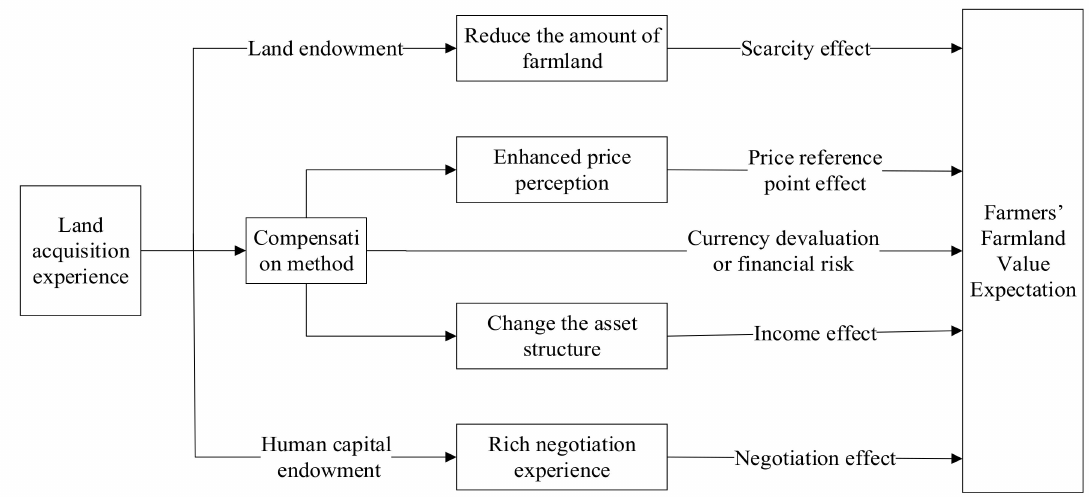
Figure 1. Theoretical analysis